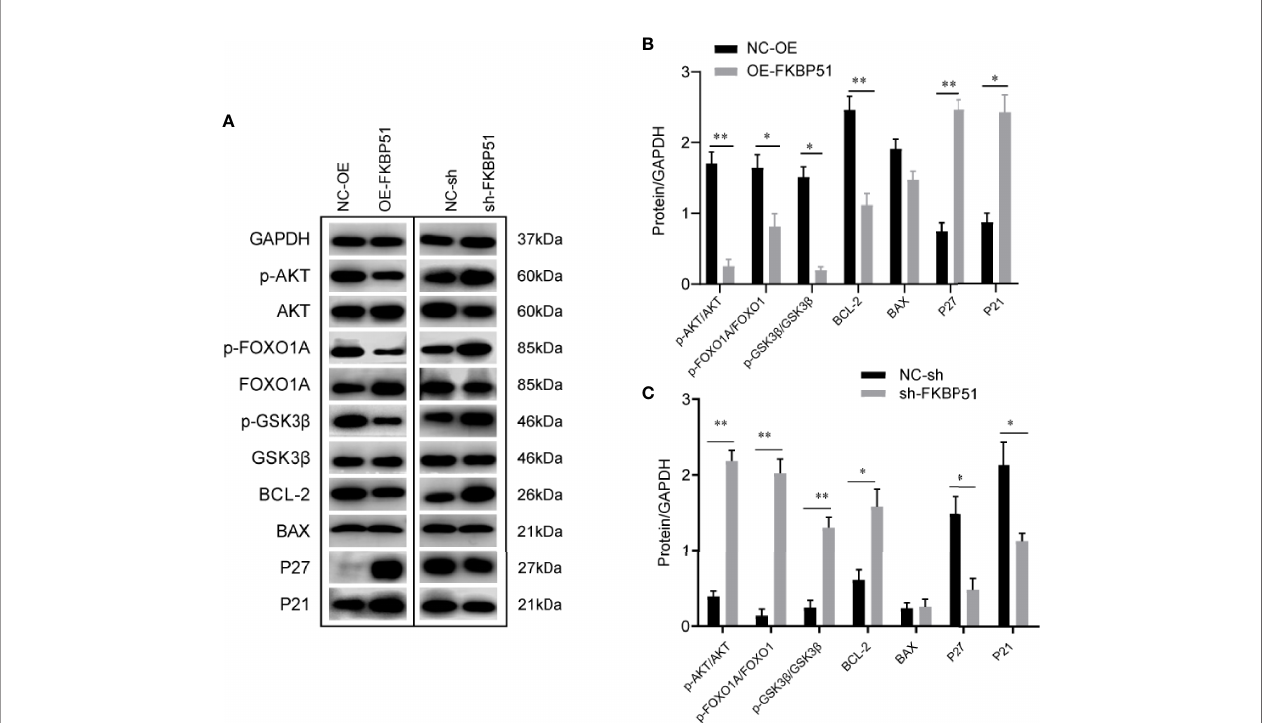
FIGURE 5 | The effect of FKBP51 on the expression level of AKT pathway-related proteins. (A) Phosphorylated (Ser473) and total AKT and AKT downstream targets (P21, P27, BAX, BCL-2, total and phosphorylated Foxo1A, and total and phosphorylated GSK3 b ) in AML-M5 cells with different expression levels of FKBP51 were detected by western blot. GAPDH was used an internal control. (B, C) Statistical results of AKT-related protein levels in FKBP51 overexpressed THP-1 cells and FKBP51-knockdown U937 cells as well as their corresponding control cells. All cells were treated with LPS (1 m g/ml) for 15 minutes before protein extraction. Each experiment was performed in triplicate. Statistical differences from negative control cells are indicated by asterisks (* for p < 0.05, ** for p <